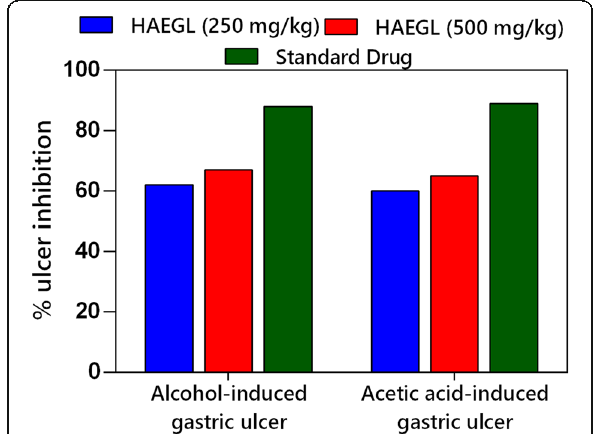
Fig. 3 Antiulcer potential of HAEGL compared with the respective standard drugs of alcohol-induced and acetic acid-induced antiulcer